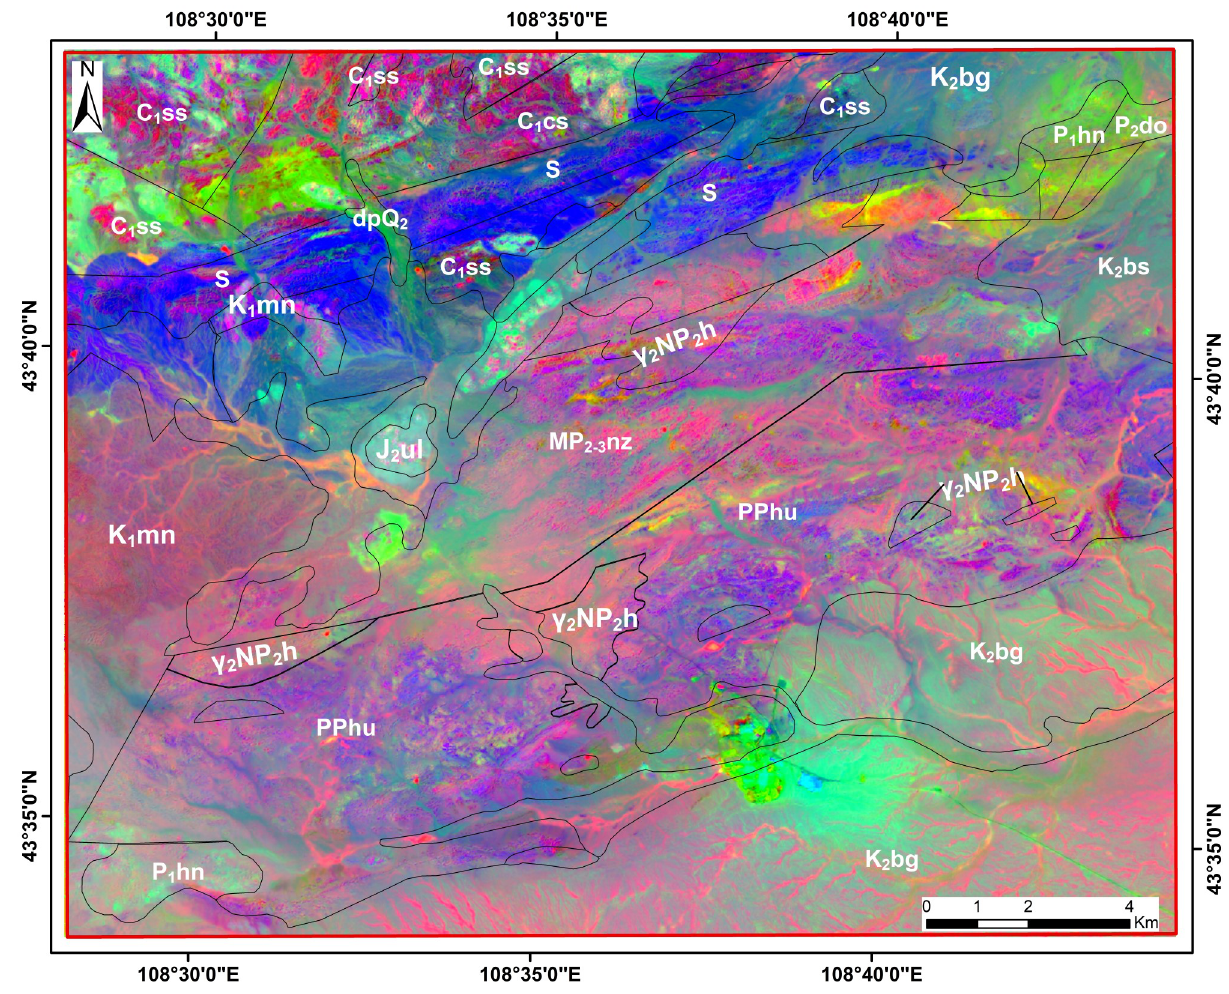
Fig. 12. (5/4, 4/7, 7/6 as RGB) false-color composite of Landsat